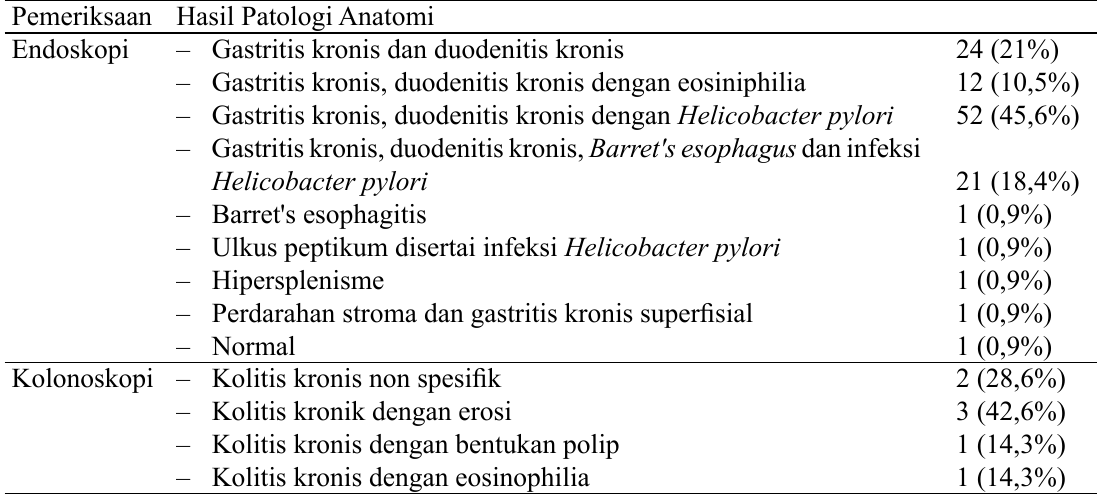
Tabel 4. Hasil pemeriksaan patologi anatomi biopsi endoskopi dan kolonoskopi Pemeriksaan Hasil Patologi